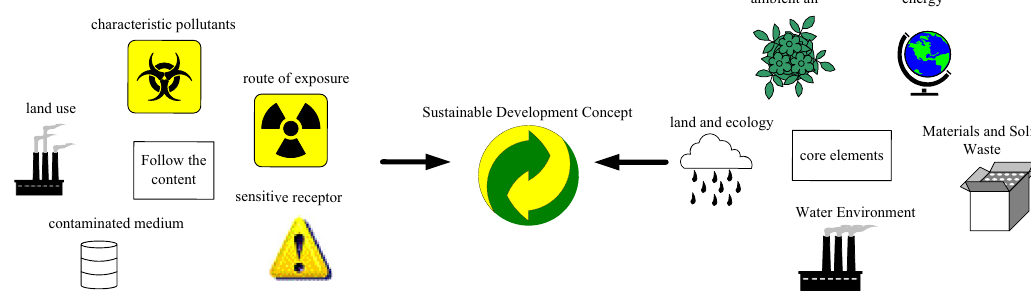
Figure 1. Decision-making perspectives of traditional and green sustainable restoration.